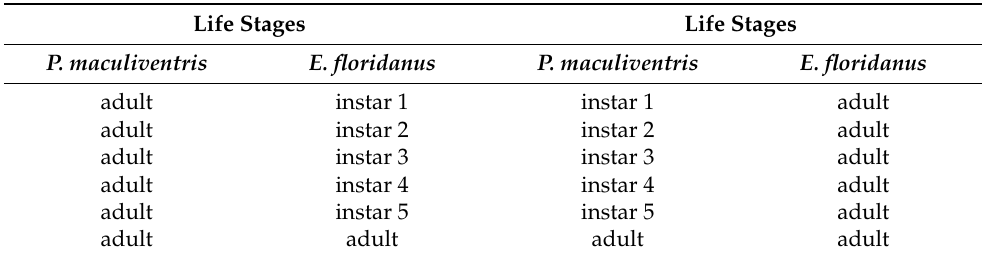
Predation pairings of adults and nymphal instars of Podisus maculiventris and Euthyrhynchus floridanus